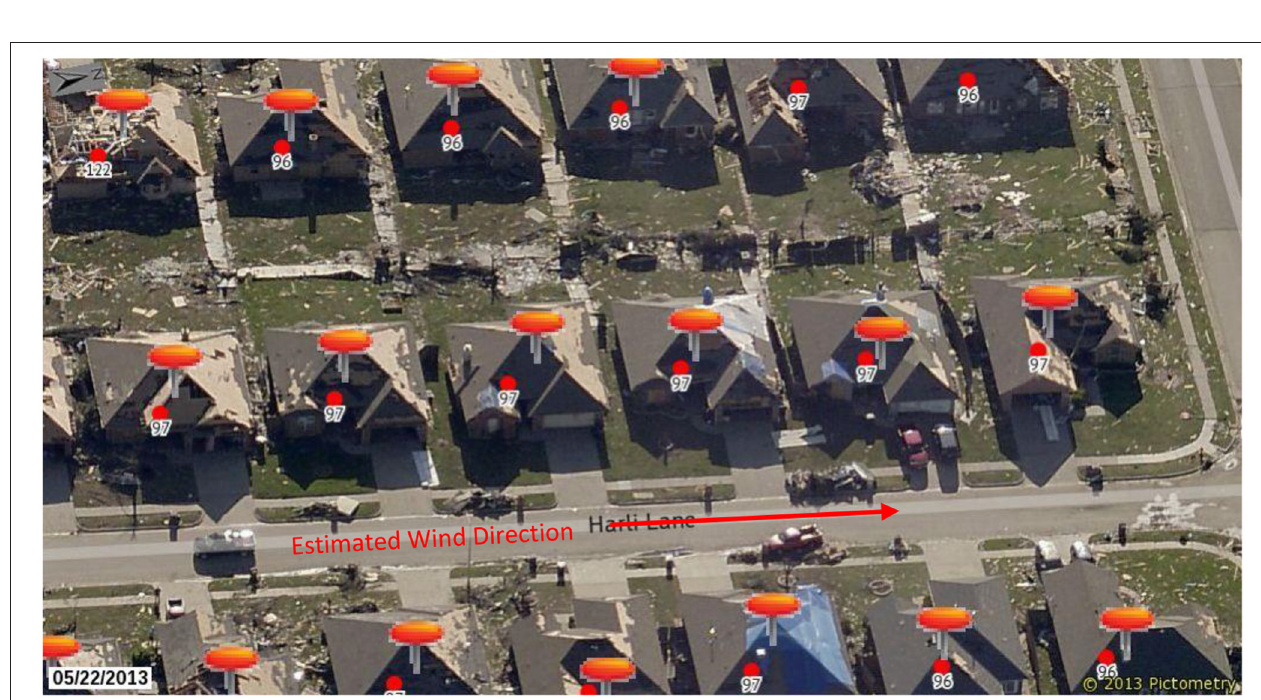
FIGURE 11 | Moore, OK Tornado Damage at Windspeeds Between 90 and 109 mph. Image resolution and quality reduced for publication. Image courtesy of Eagleview Technologies, Inc.